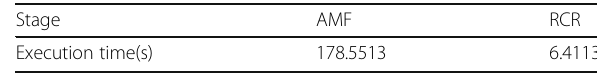
Table 5 Execution time of three main stages in the